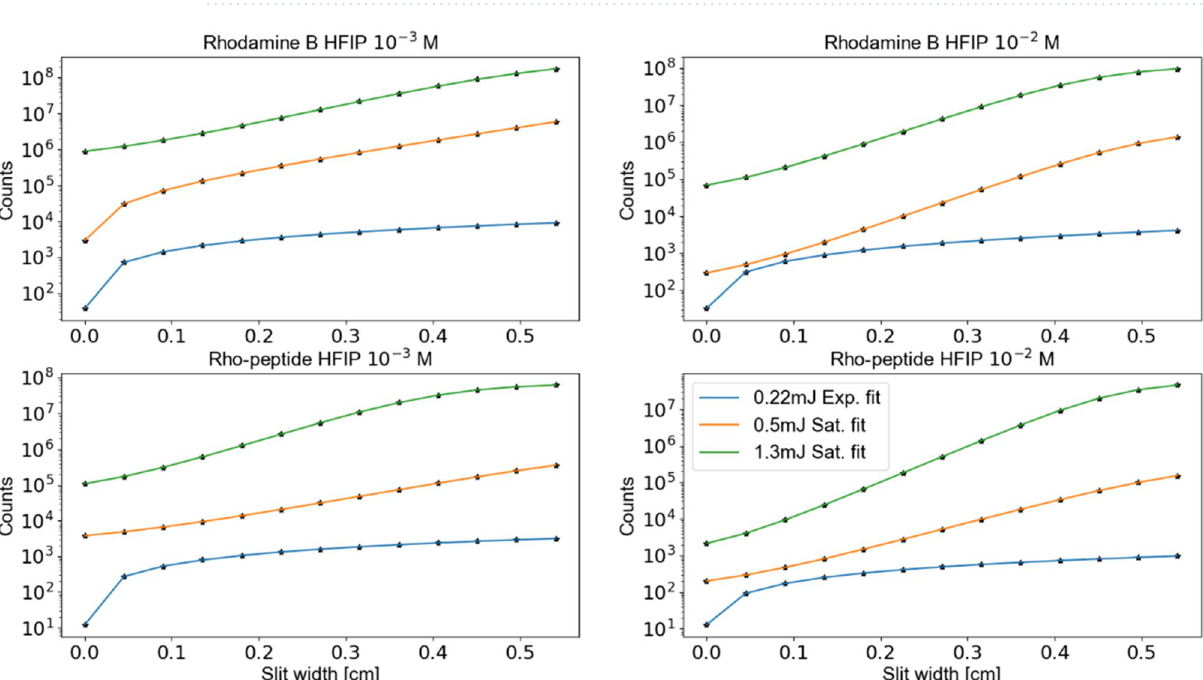
Figure 6. Fluorescence intensity as a function of the slit width. Three pump laser intensities were tested and appear in legends. Numerical data (black dots) is fit with exponential and saturation models – Eqs. 1(a) and (b), respectively. Material, molar concentrations and other information appears in legends and